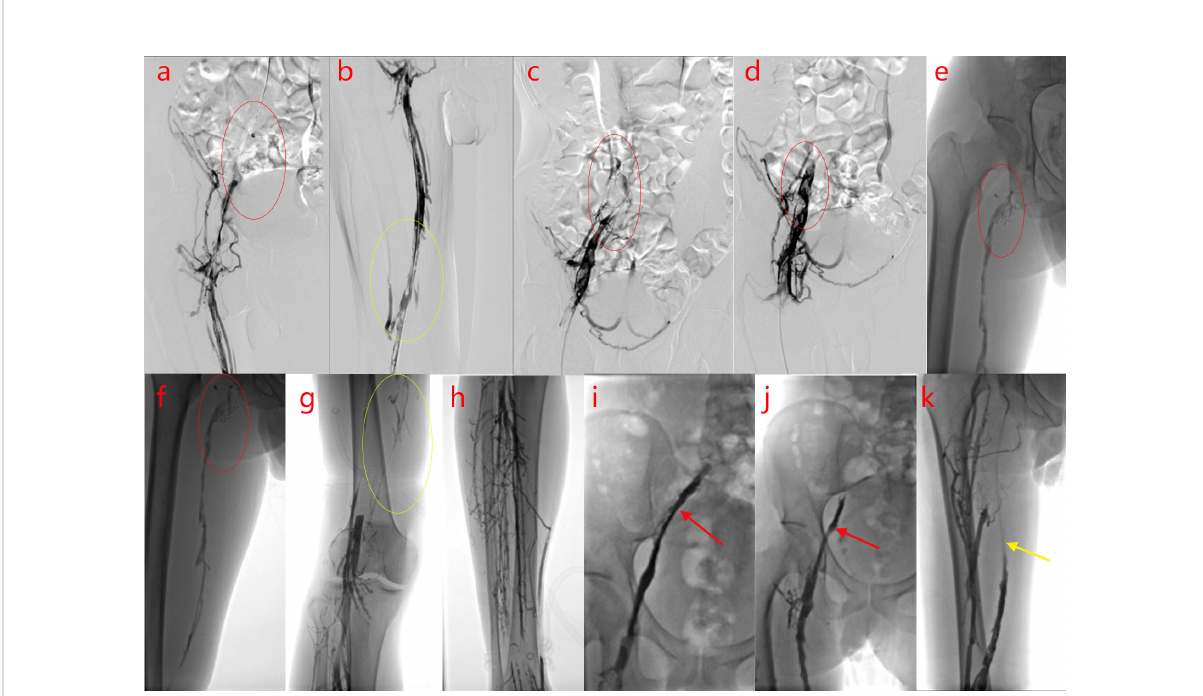
FIGURE 1 Digital subtraction angiography (DSA) of the right inferior vena cava examination. (A – H) .Before thrombolysis surgery, DSA of the patient reveals occlusion of the right common iliac vein (CIV) and right external iliac vein, with plenty of collateral vessels and extensive fi lling defects in the proximal and middle segments, exhibiting a stenosis degree of 50% – 90% (A – F) femoral vein, (G) popliteal vein, (H) deep calf vein; the arrows and circles of different colors in the fi gures indicate the focus]. (I – K) . After thrombolysis surgery, DSA examination of the patient shows recanalization of the femoral vein (the arrows and circles of different colors in the fi gures indicate the